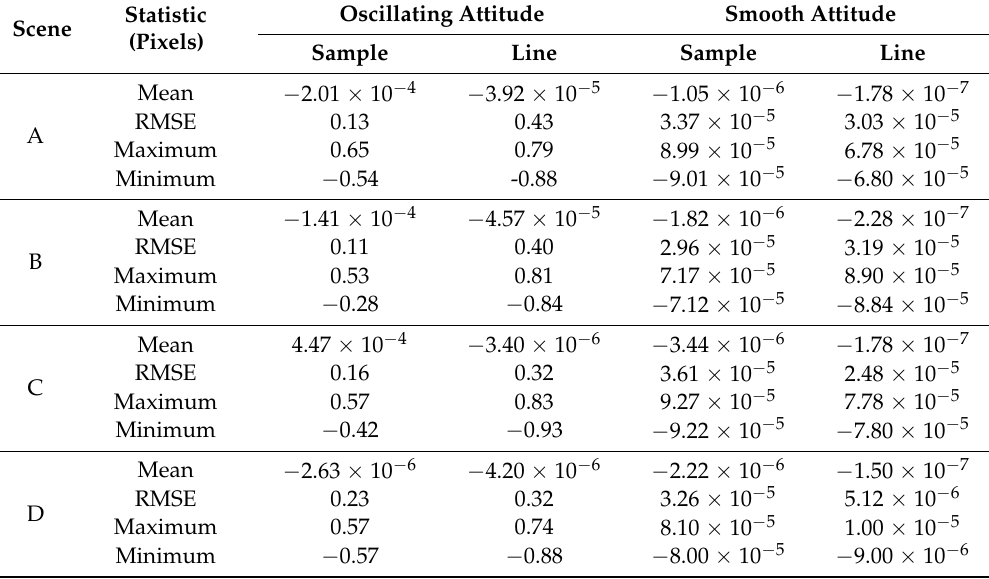
The maximum and minimum error absolute values for the rational function coefficients